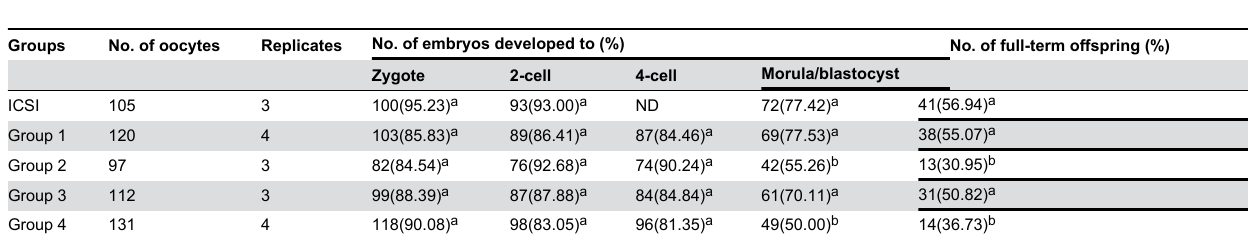
Table 1. Effect of GV cytolysate and nucleolus on the development and birthrate of ROSI-derived embryos.